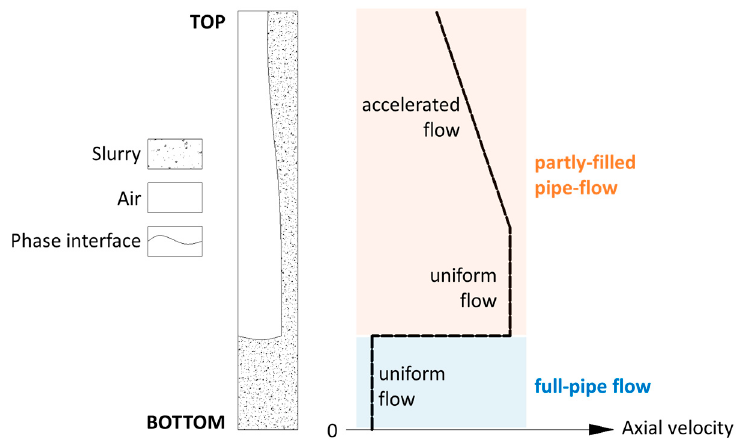
Figure 11. Idealized curve of slurry axial velocity with vertical pipe depth.